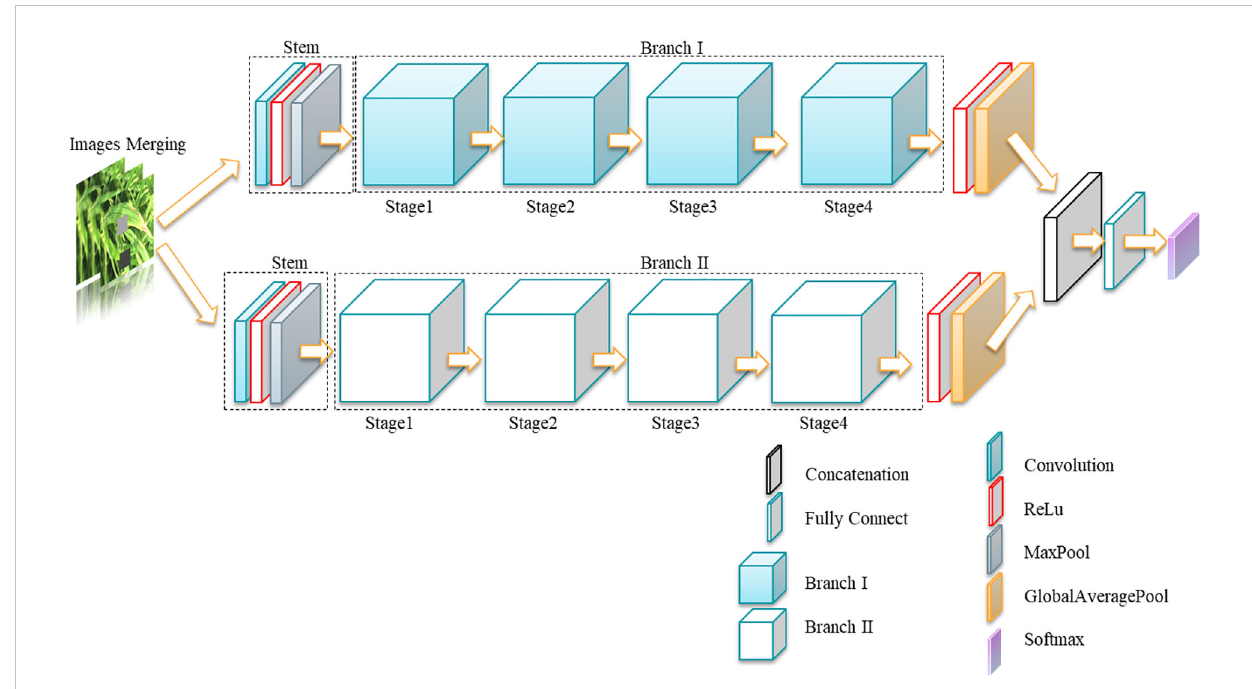
FIGURE 7 Proposed MSDB-ResNet architecture.